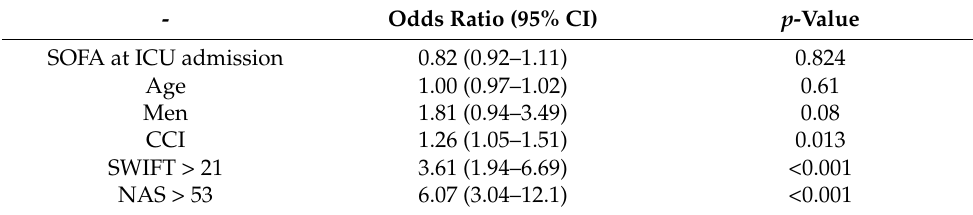
Table 3. Multivariate analysis of factors for prediction of unplanned ICU